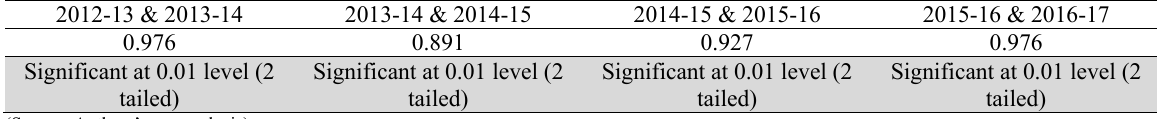
Correlation between year to year PB based ranks